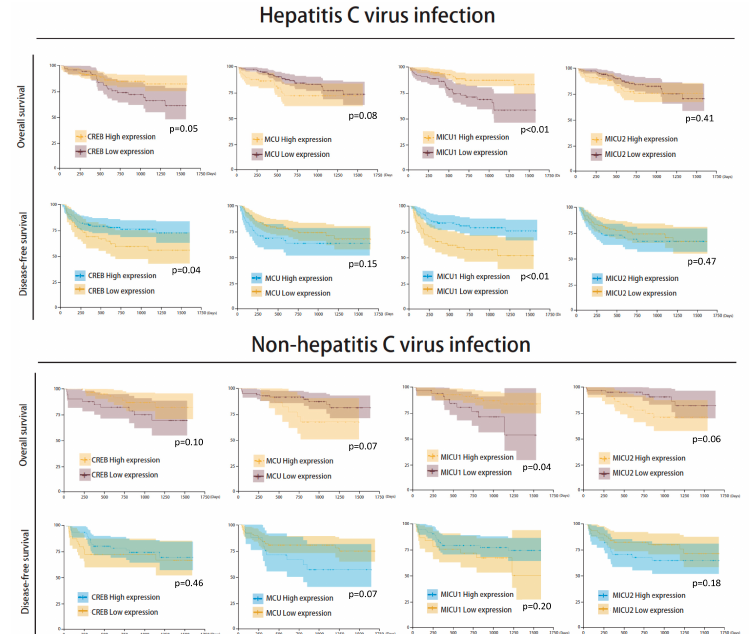
Figure 8. Kaplan–Meier analysis of four mitochondria gene expression in HCV/non-HCV infection subgroup analysis. Biomedicines 2020 , 8 , x FOR PEER REVIEW